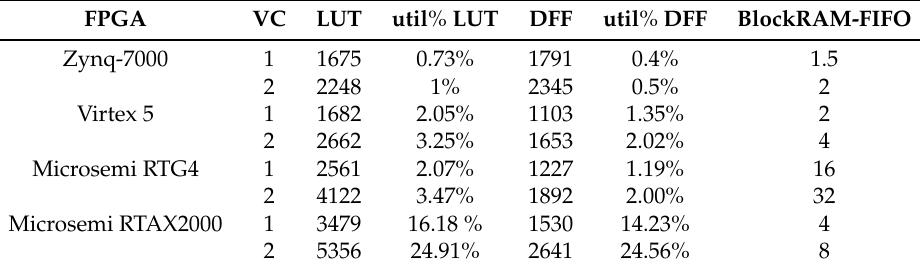
Table 1. R-SpaceFibre COder-DECoder (CODEC) resource utilisation on different Field Programmable Gate Arrays (FPGAs).